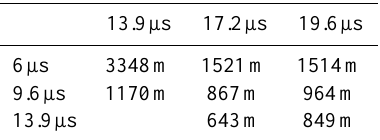
Table 2. Inter-layer attenuation lengths, calculated from amplitudes measured for returns and assuming uniform reflectivity of all lay- ers, as discussed in text. First column indicates first reflecting layer; successive columns indicate second reflecting layer used to calcu- late attenuation length via Friis equation. Estimated errors are of the order 30%.